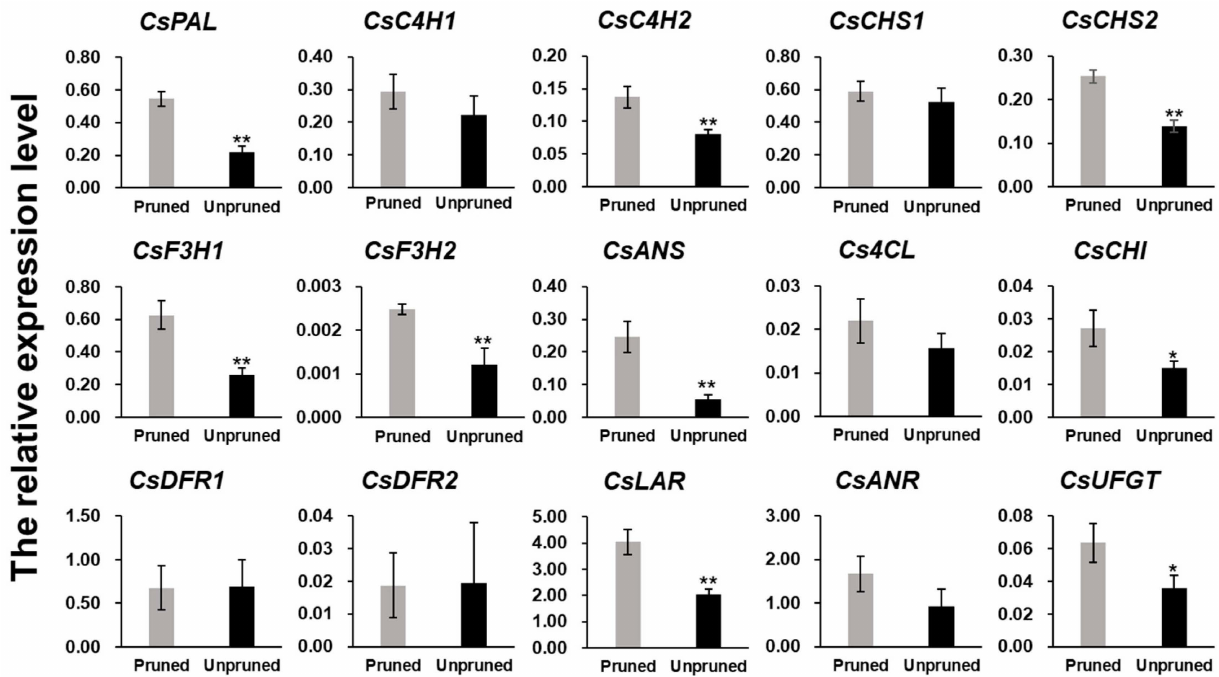
Figure 4. Relative expression levels of candidate genes by quantitative real-time PCR. The data were analyzed by t test, * represents significant difference ( p < 0.05), ** represents extremely significant difference ( p < 0.01). 4CL,